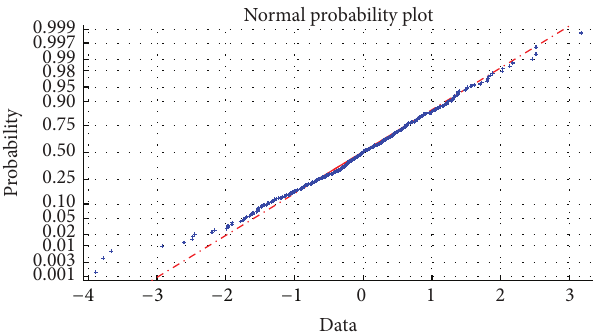
Figure 8: Normal probability plot of standardized residuals.